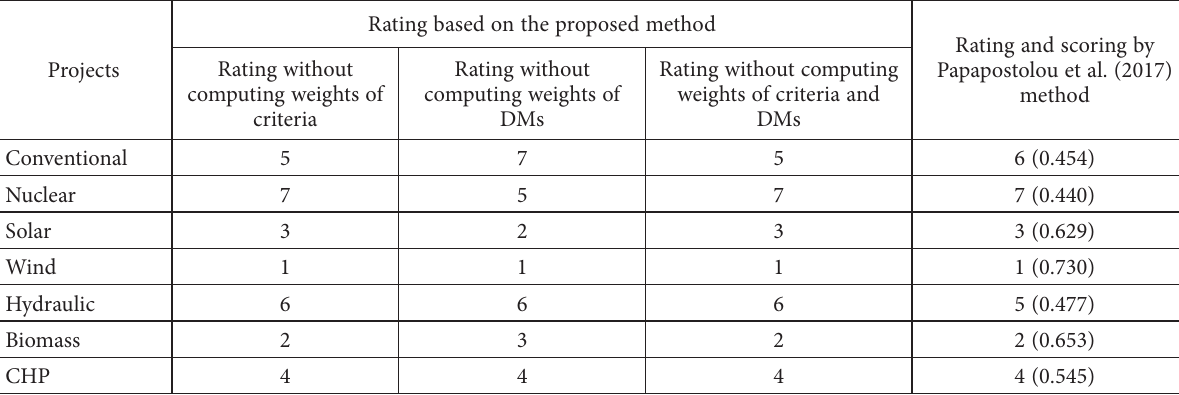
Rating and scoring by Papapostolou et al. (2017) methodRating without